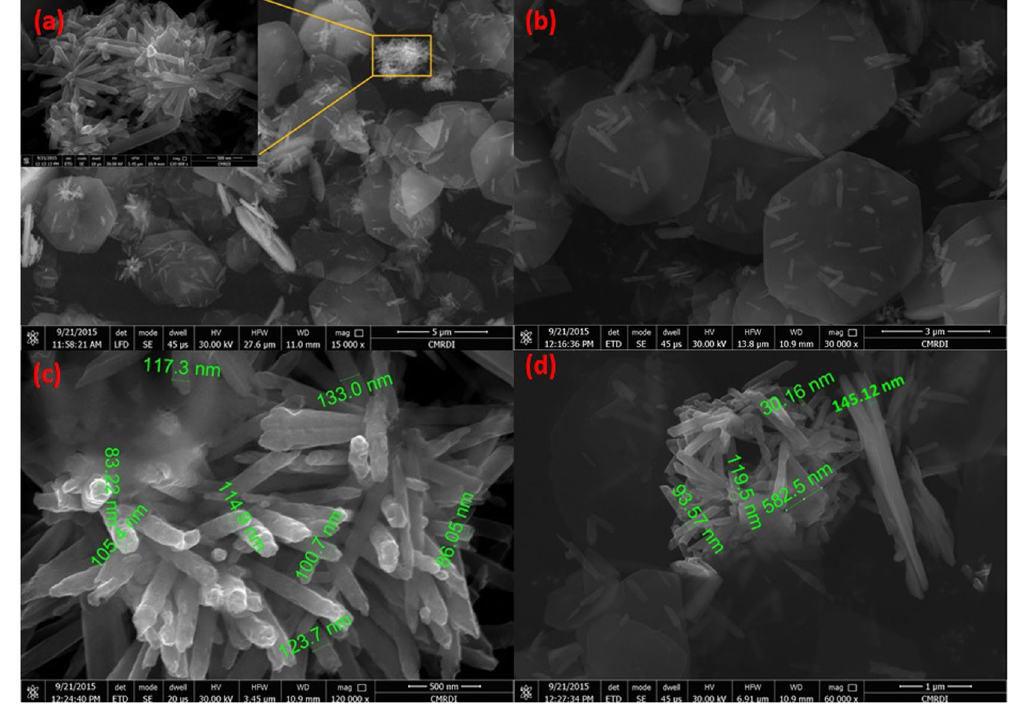
Figure 6. FESEM images of ZnO oxide nanoflower over nanoplatelets ( a ), dispersed ZnO oxide nanorods over nanoplatelets ( b ), collection of ZnO oxide nanorods ( c ), and ZnO oxide nanocage over nanoplatelets ( d ).